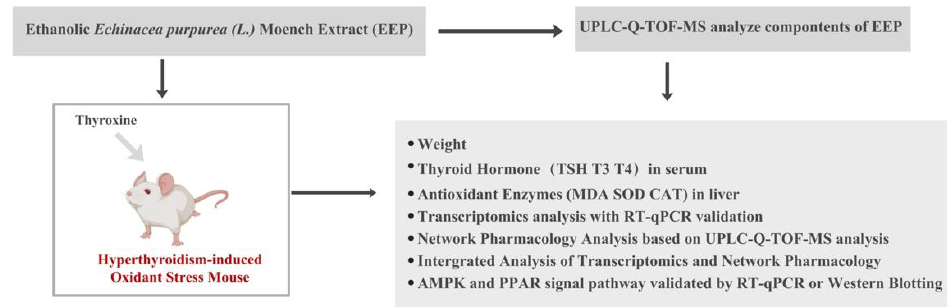
Figure 12. Workflow of methodologies applied in the study.